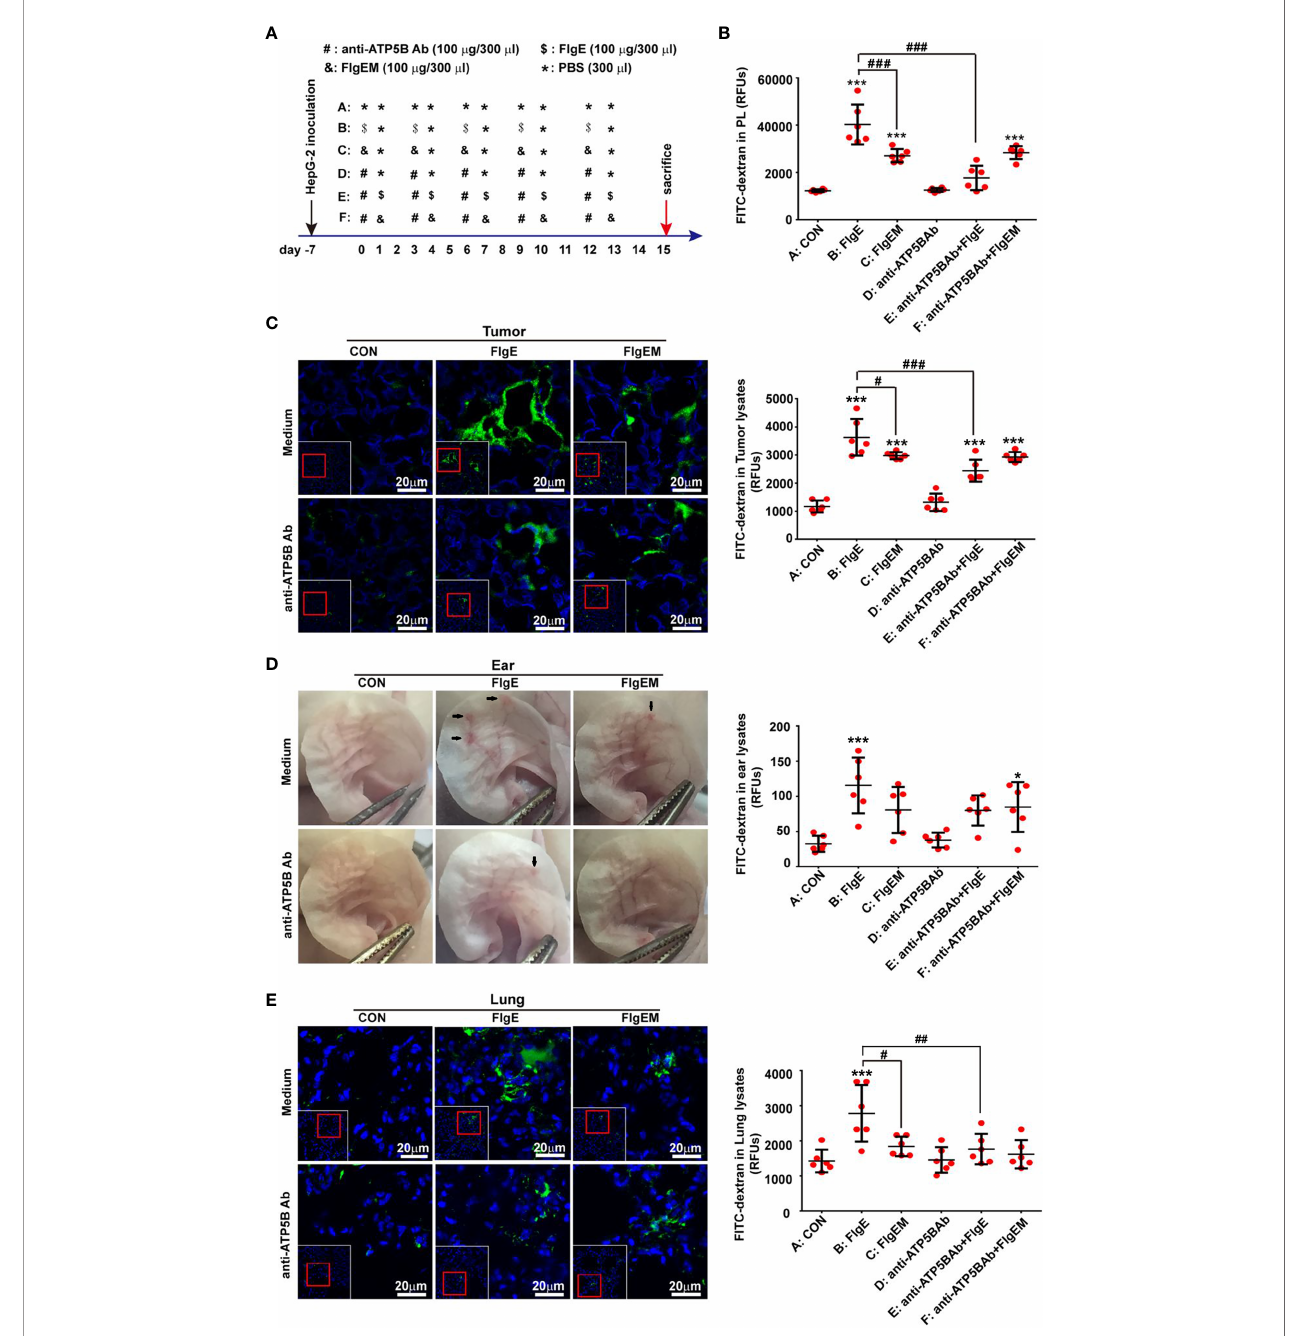
FIGURE 1 | FlgE-induced vascular permeability in tumor-bearing animal models was alleviated by anti-ATP5B antibodies. Thirty-six 4-week-old nude mice were inoculated with 10 7 HepG2 cells subcutaneously at the right anterior armpits. A week later, the mice were divided into six groups and received different treatments (A) . On day 15, images of ears were captured before receiving 0.2 ml of FITC-dextran (2.5 mg/ml) via tail vein. Thirty minutes later, mice were anesthetized, and cardiac perfusion was performed with 20 ml of PBS. The abdominal cavity was lavaged with 1 ml of PBS to generate peritoneal lavage fl uid (PL) (B) . Tumor mass (C) , ears (D) , and lungs (E) were harvested. Tissues were either homogenized directly for fl uorescence measurement as in abdominal ascites (B – E) or fi xed and subjected to confocal microscopy examination after nuclear labelling with DAPI, where leaked dextran was seen as green (C, E) . Arrows in (D) indicate leakages seen by the naked eyes. Scale bar, 20 m m. Representative images are shown for either histological sections or gross ears. Quanti fi cation of leaked FITC-dextran in lungs or tumors tissues was expressed as fl uorescence units per micrograms of homogenates. Data are representative of duplicate independent experiments with similar results. * p < 0.05, *** p < 0.001 vs . control (CON). # p < 0.05, ## p < 0.01, ### p < 0.001 vs . FlgE, all by one-way ANOVA test. HUVECs, human umbilical vein endothelial cells; SVECs, SV40-transformed endothelial cells of mouse; VECs, vascular endothelial cells; FITC, fl uorescein isothiocyanate; PBS, phosphate-buffered